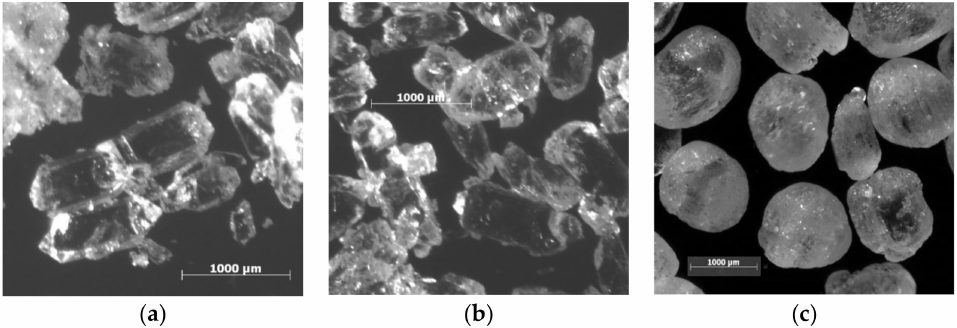
Figure 8. ( a ) Crystals after 1.5h of continuous crystallization in bench scale DTB (d´ = 956 µ m); ( b ) crystals after 6h (d´ = 1149 µ m); ( c ) crystals after 10h (d´ = 1435 µ m).